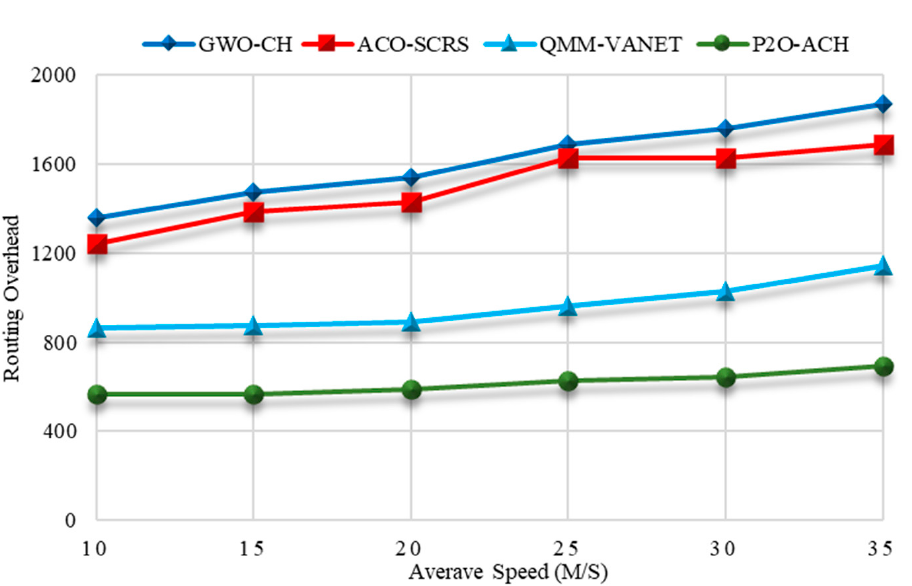
Figure 16. Routing Overhead Calculation.